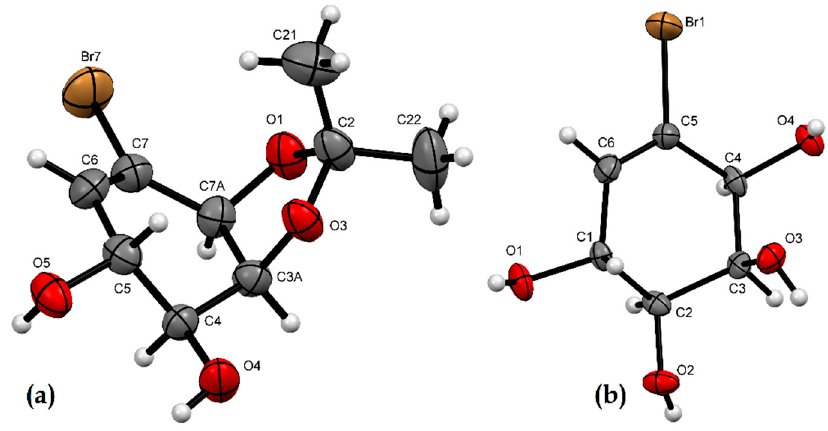
Figure 2. ORTEP plots of ( a ) bromo-conduritol C acetonide ( 11 ), and ( b ) ( − )-bromo-conduritol C ( 12 ).